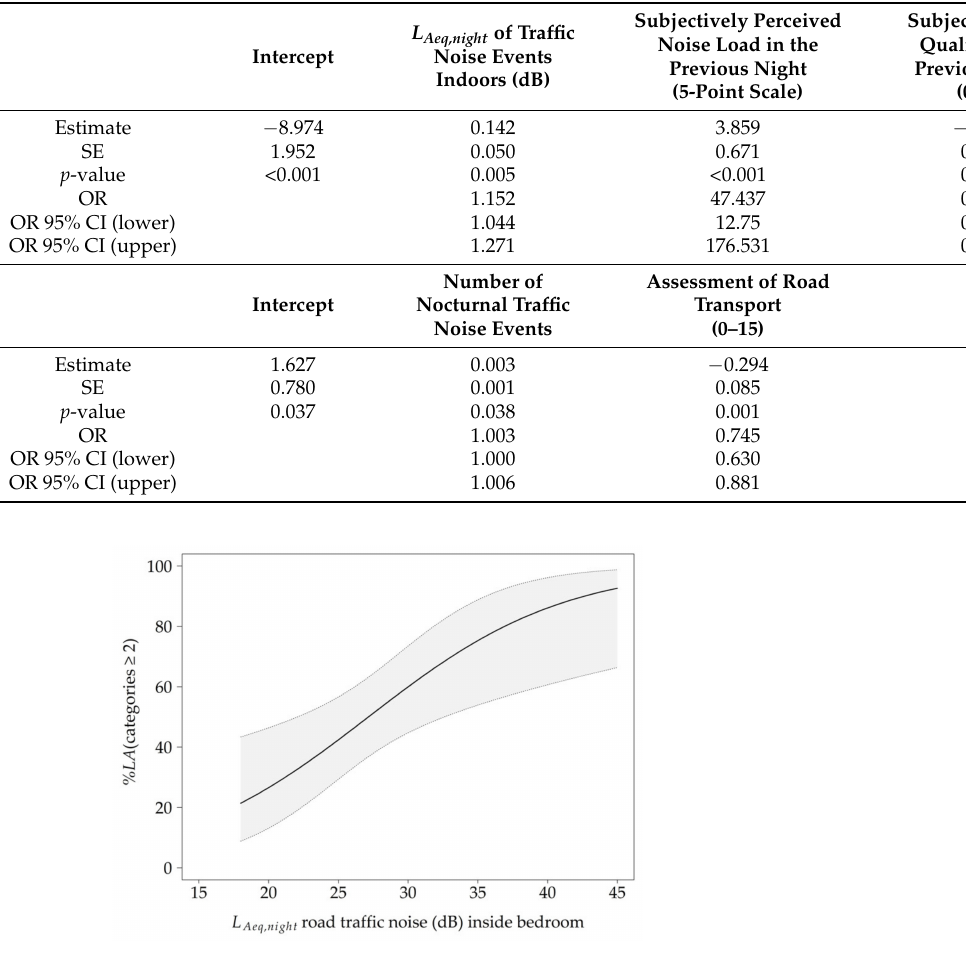
Figure 2. Exposure–response curve for the probability to be annoyed at least a little ( %LA ) due to the A-weighted energy equivalent sound level, L Aeq,night , of nocturnal road traffic noise measured inside the bedroom. Other covariates were set at their respective median (subjectively perceived noise load = 2; subjective sleep quality = 38.8). The grey area represents the 95% confidence